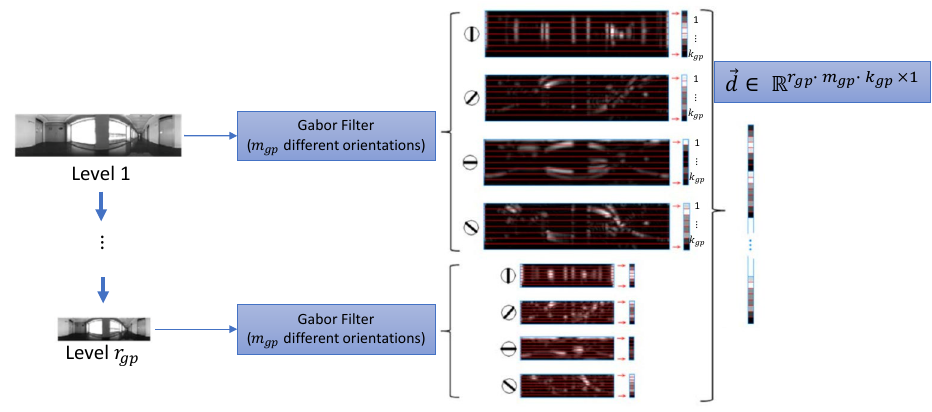
Figure 3. Process to build the gist descriptor using horizontal